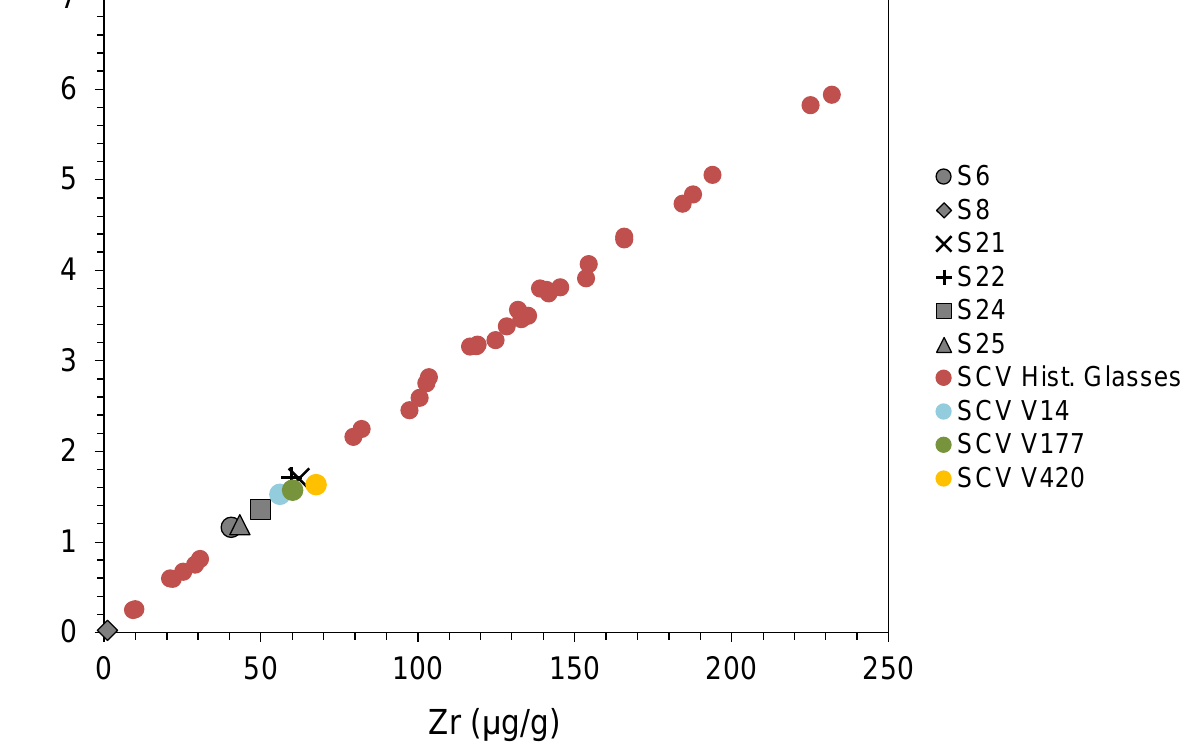
Figure 7. Binary chart of zirconium vs. hafnium for SCV historical glasses and for the synthesised glasses in micro grams per gram.